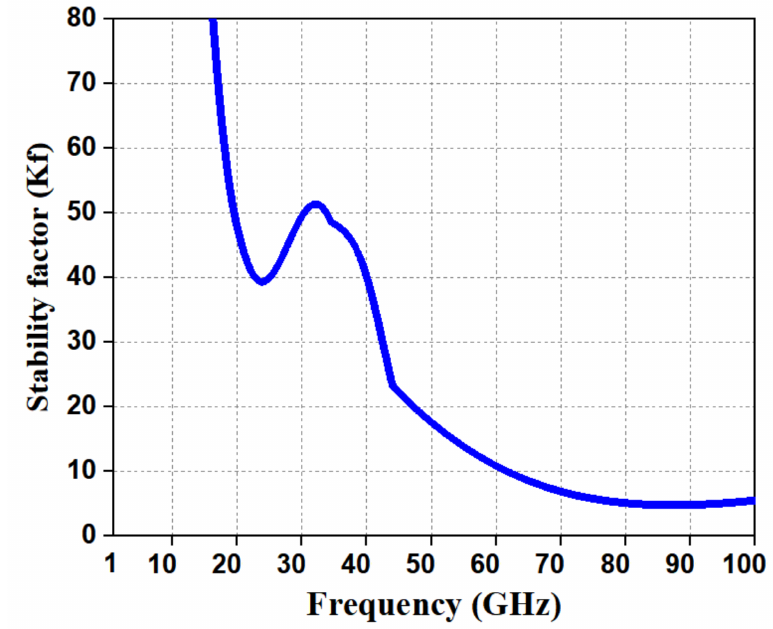
Figure 15. Stability factor (Kf) of the